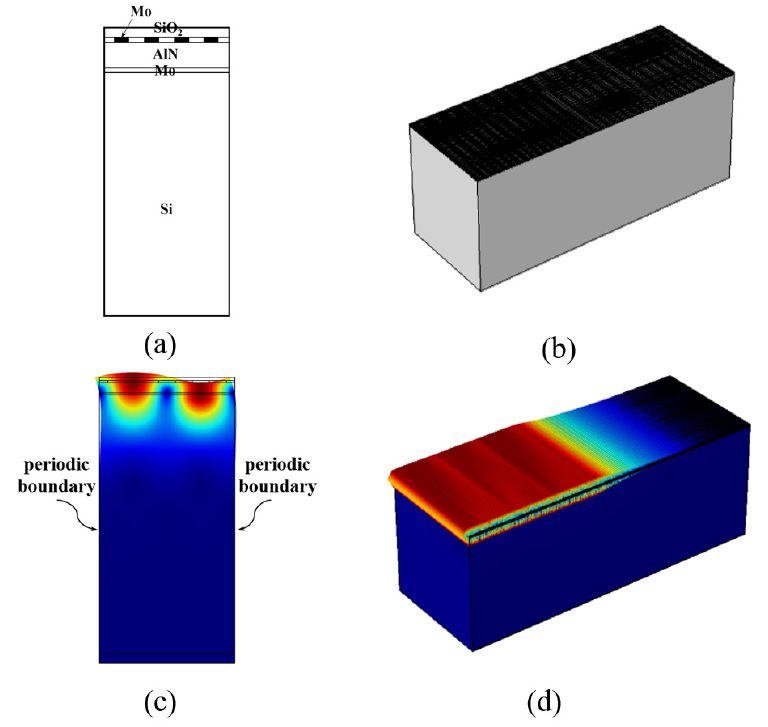
Figure 1. Illustration of 2D and 3D FEA models and simulated displacement profiles of the QSAW resonators: ( a ) Simplified 2D FEA model structure. ( b ) 3D FEA model structure. ( c ) 2D FEA displacement profile. ( d ) 3D FEA displacement profile.